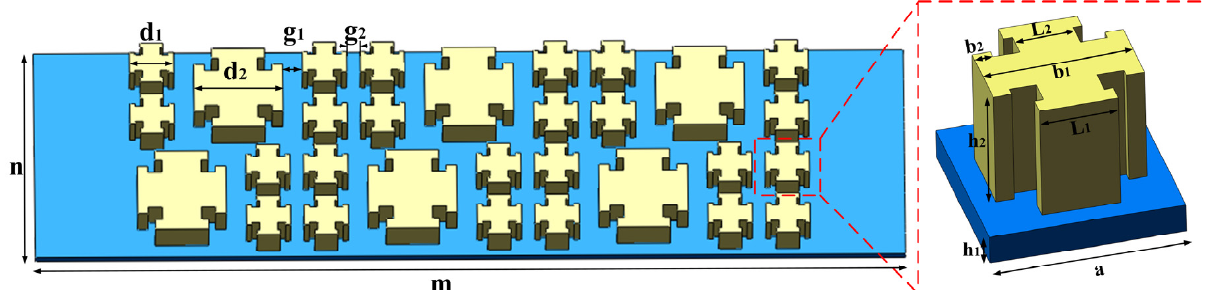
Figure 1. The schematic of the metamaterial and the corresponding unit cell, which comprises a square resinic substrate and a notched cross-shaped steel mass block. square resinic substrate and a notched cross-shaped steel mass